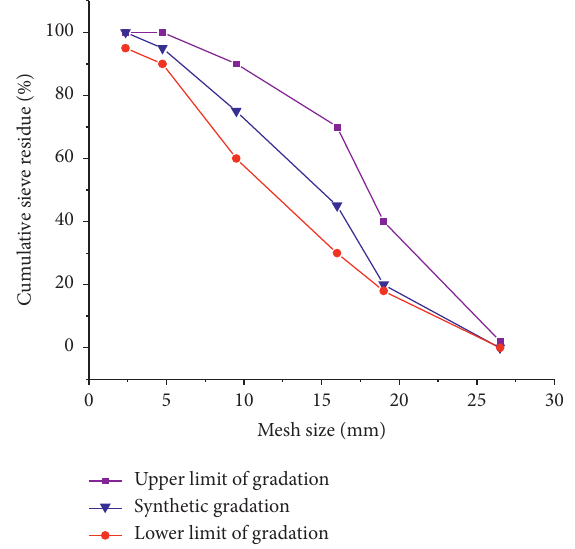
Figure 2: Grading curve of coarse aggregate. Table 5: Technical specification of river sand.